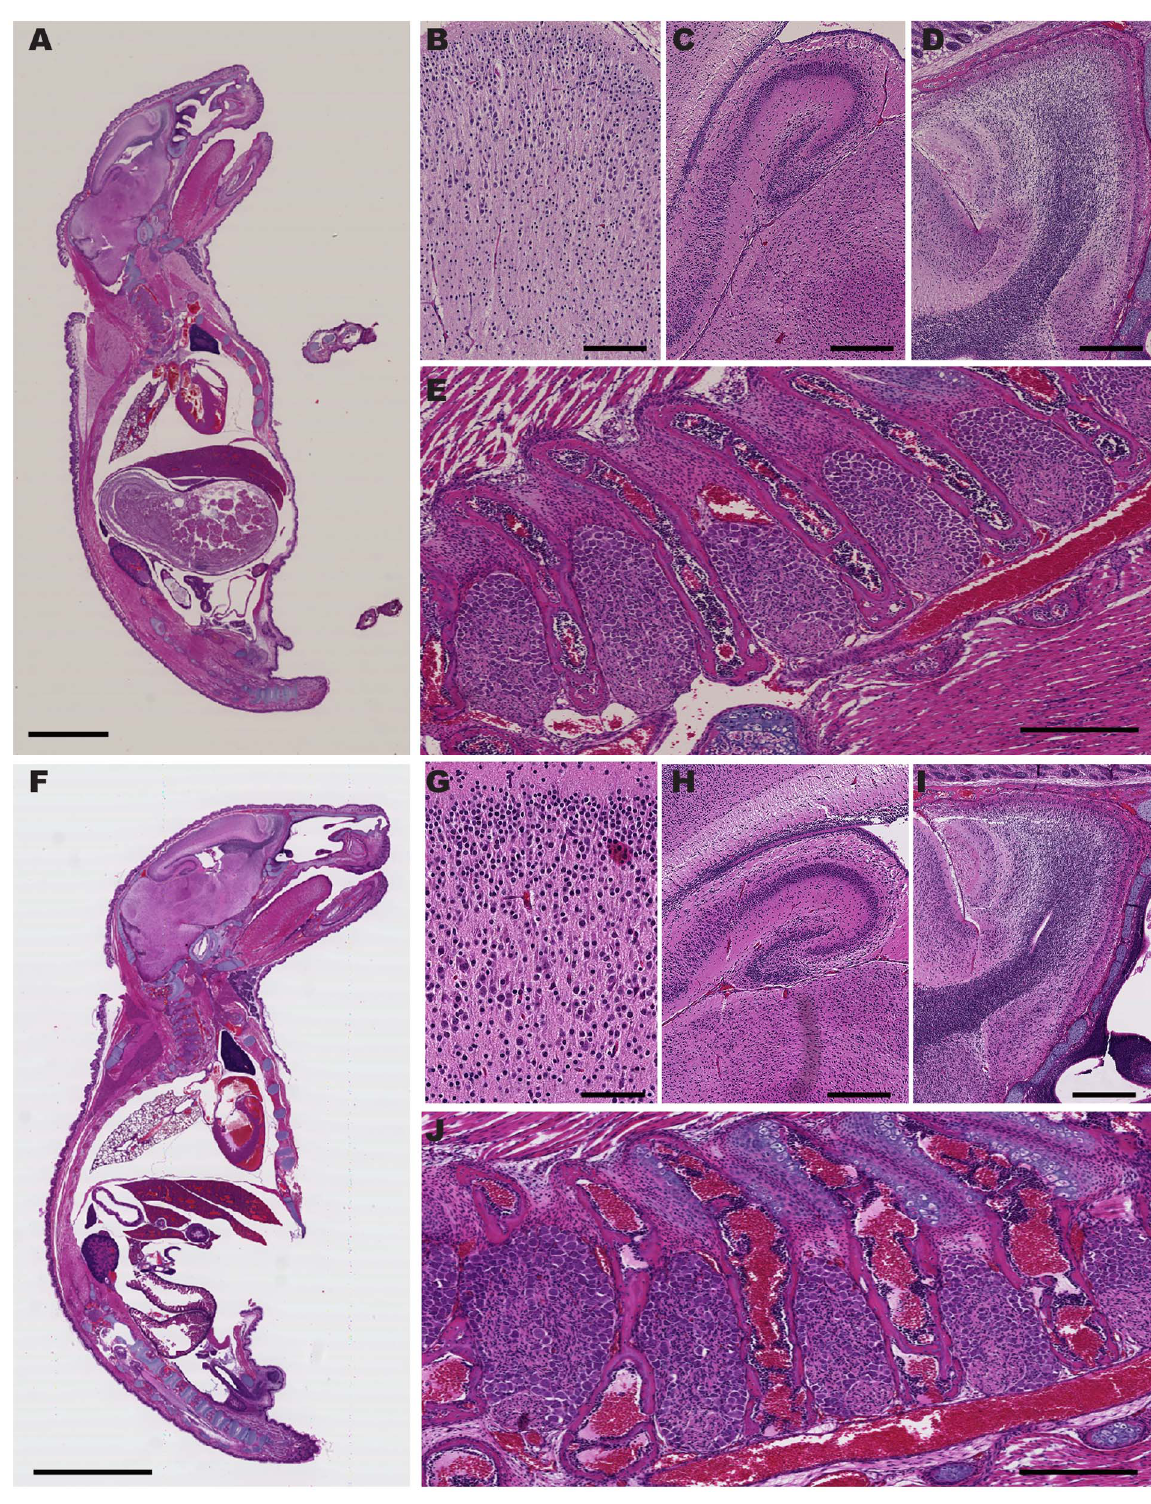
Figure 2. Normal anatomy of Nav1.7 KOs. Postnatal day 4 Nav1.7 WT (A to E) and KO (F to J) neonates stained with hematoxylin and eosin (H&E). Wild type: A. Sagittal section of the entire pup. B through E show magnifications of various regions of the central and peripheral nervous systems: Knock Out: F. Sagittal section of the entire pup. G through J show magnifications of various regions of the central and peripheral nervous systems. ( B, G ) cortex; ( C, H ) hippocampus; ( D, I ) olfactory bulb; ( E, J ) dorsal root ganglia. (Scale bars: A, F =5 mm; B, G =100 m m; C, H and D, I =400 m m; E, J =300 m m).